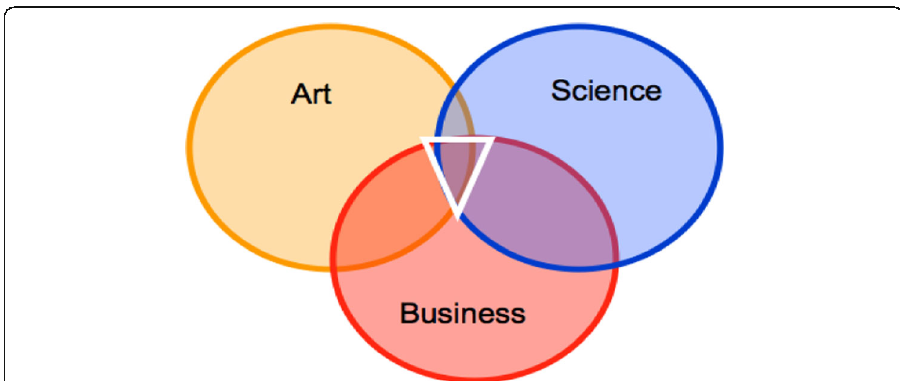
Fig. 2 Model of the Intersection of Art, Science and Business. © 2015 Kunstmuseum